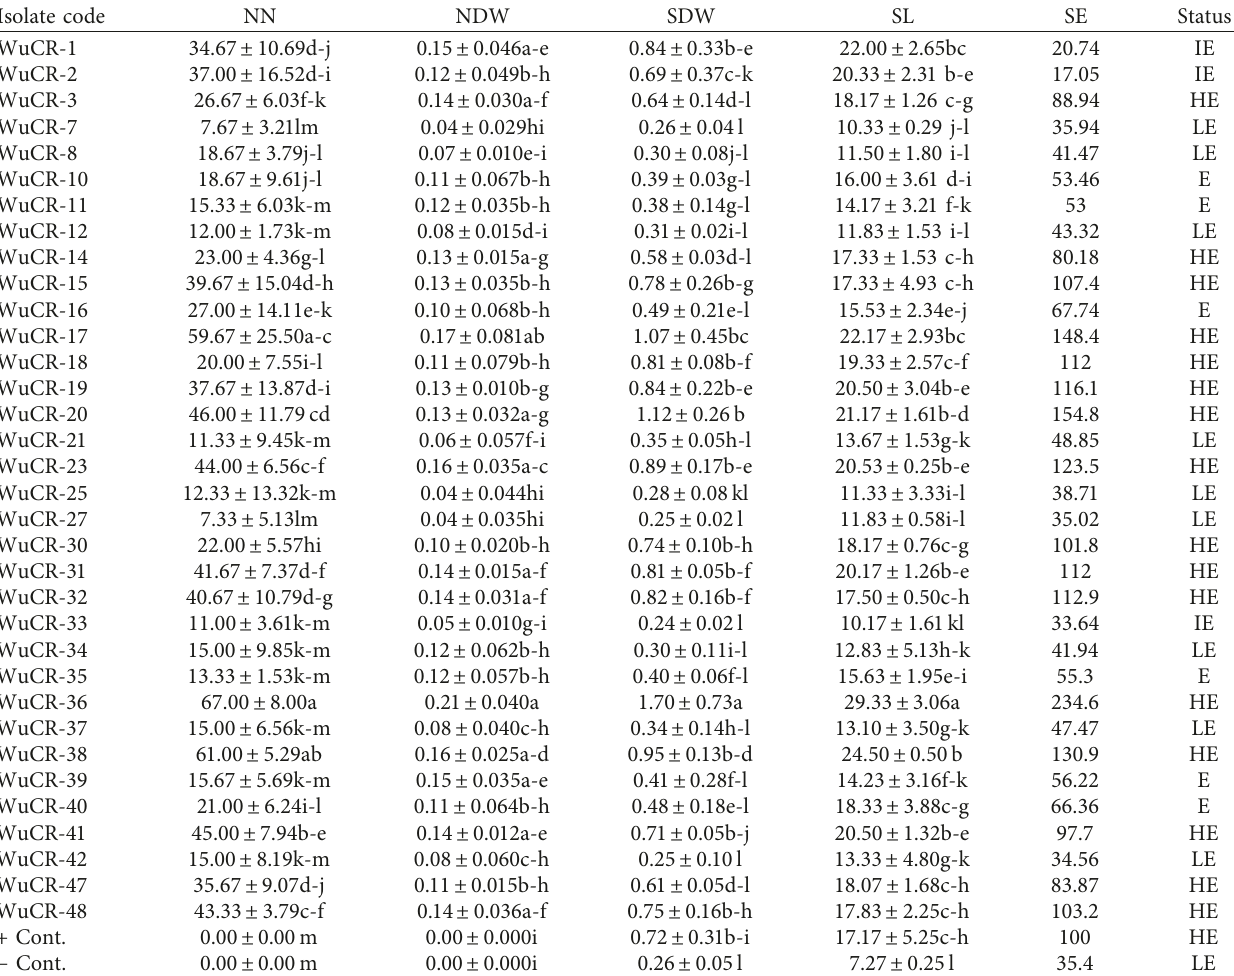
Table 2: Performance of selected Rhizobium isolates on potted sterilized sand under greenhouse conditions. Isolate